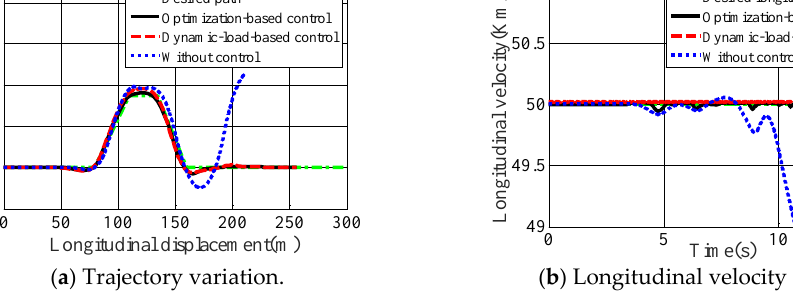
( a ) Trajectory variation. ( b ) Longitudinal velocity variation. Figure 9. Cont